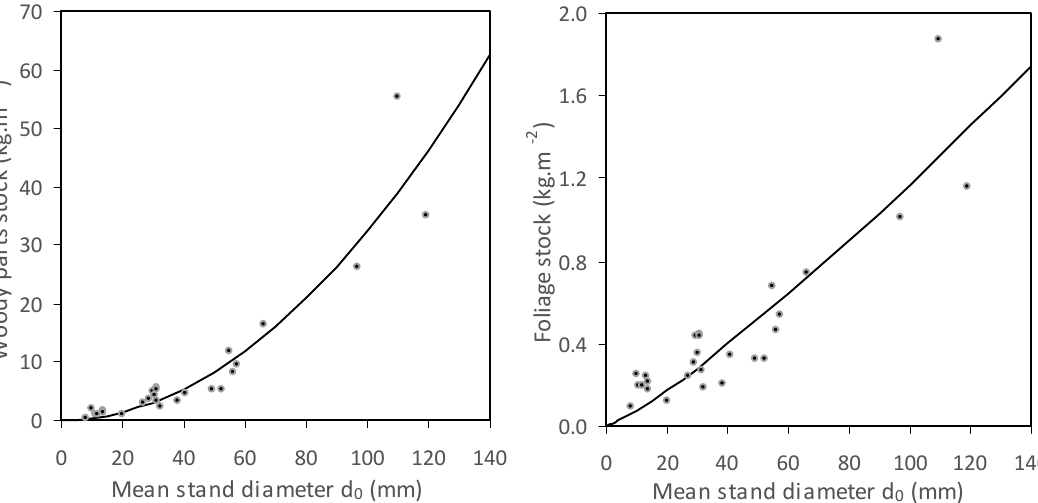
Figure 6. Leaf area ratio (left plate) and leaf mass ratio (right plate) plotted against the d 0 stem base diameter of the sampled common aspen trees (see also Table 3).